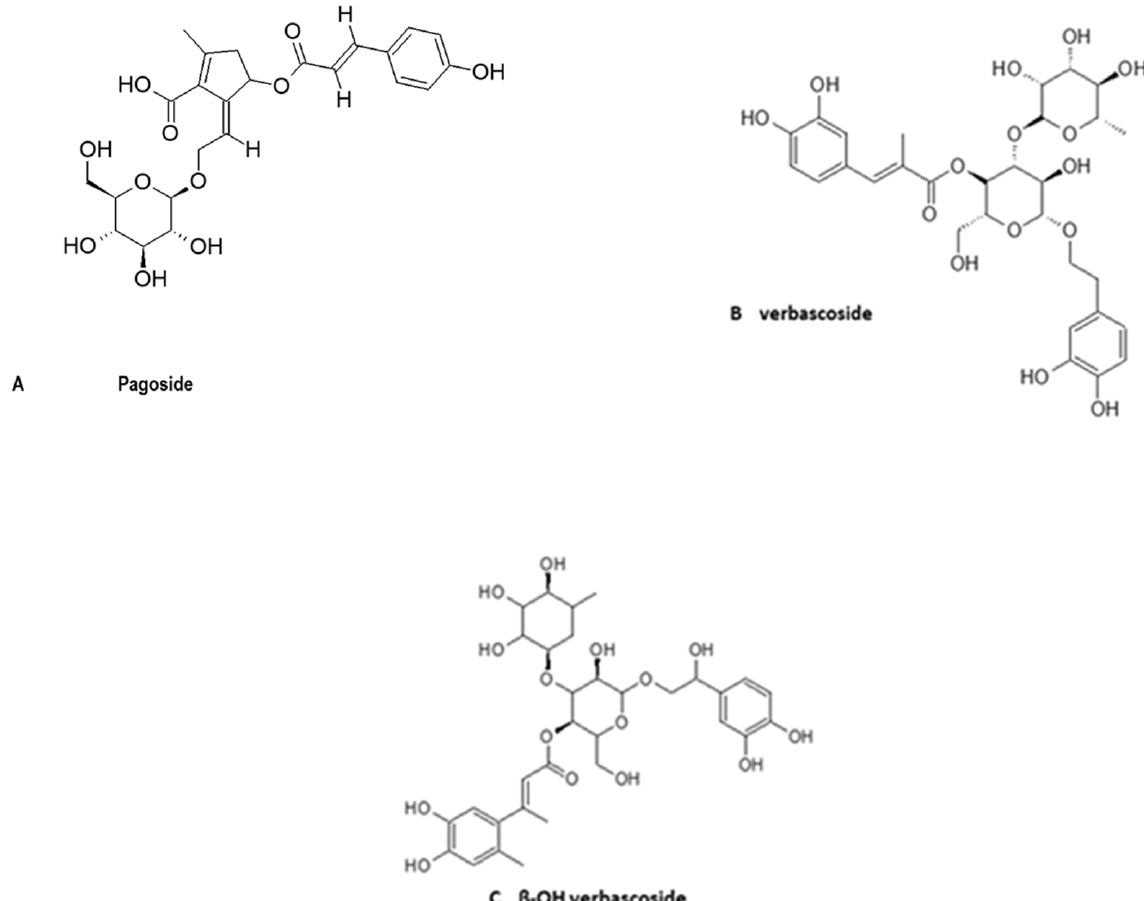
Figure 4. Chemical structure of the phenolics; phenolic glycosides of H. procumbens [29].